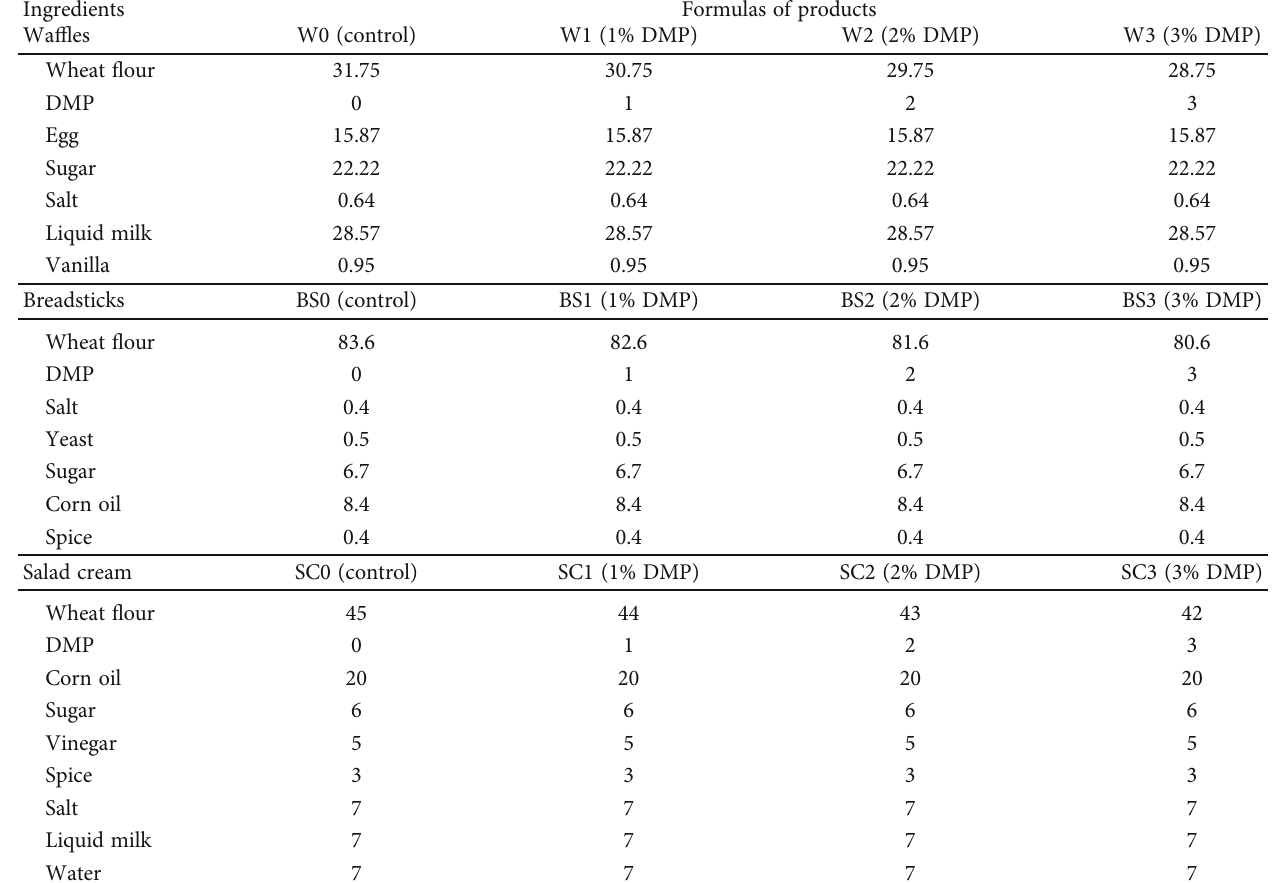
Table 1: Ingredients used for the preparation of wa ffl es, breadsticks, and salad